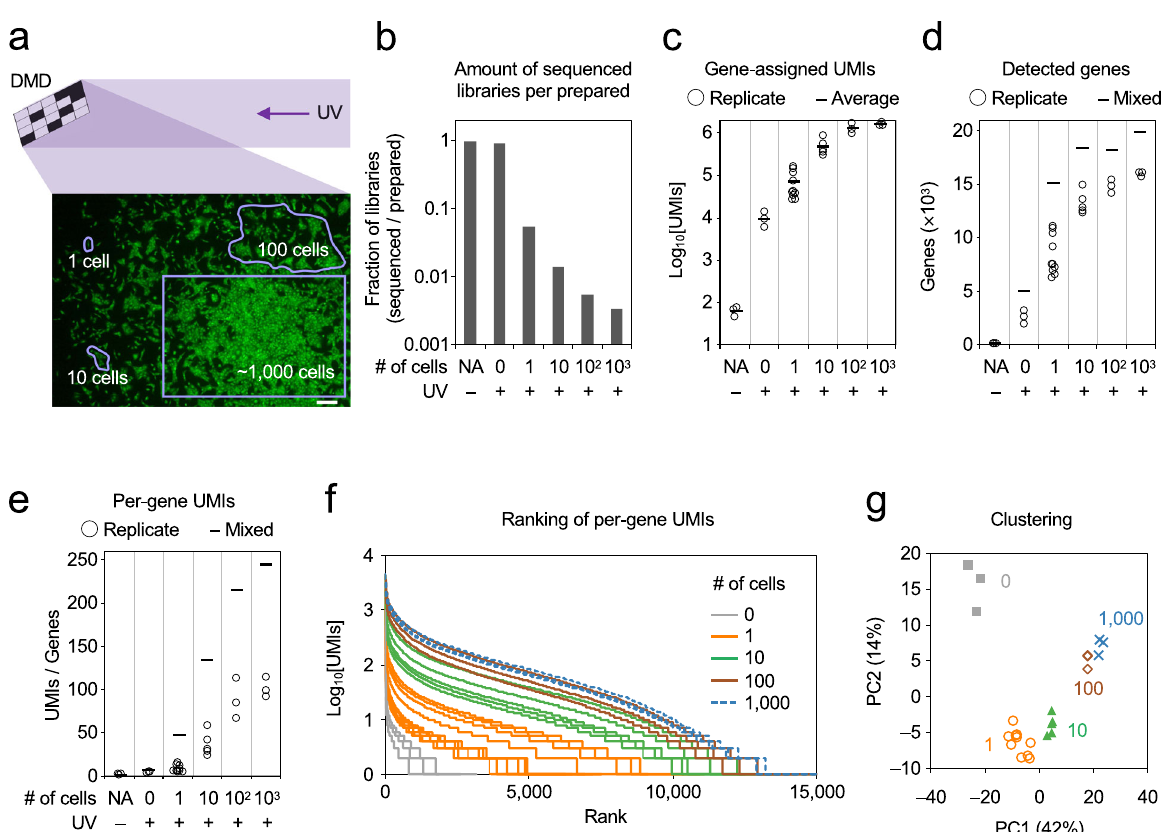
Fig. 4 Sensitivity of PIC with RNA-seq under DMD illumination. a Illustration of the experiments for DMD-assisted UV irradiation of 1 ( n = 10), 10 ( n = 5), 100 ( n = 3), or ~1000 ( n = 3) cells. Scale bar, 200 μ m. b The amounts of the sequenced libraries relative to UV – samples (set as 1) are shown. c – e The numbers of gene-assigned UMIs ( c ), detected genes ( d ), and per-gene UMIs ( e ) are shown, with the horizontal lines indicating the average of replicates ( c ) and values when the replicates were mixed ( d , e ). f Per-gene UMIs and the rankings are shown. g Two-dimensional PCA for the expression pro fi les. Source Data is available as a Source Data fi